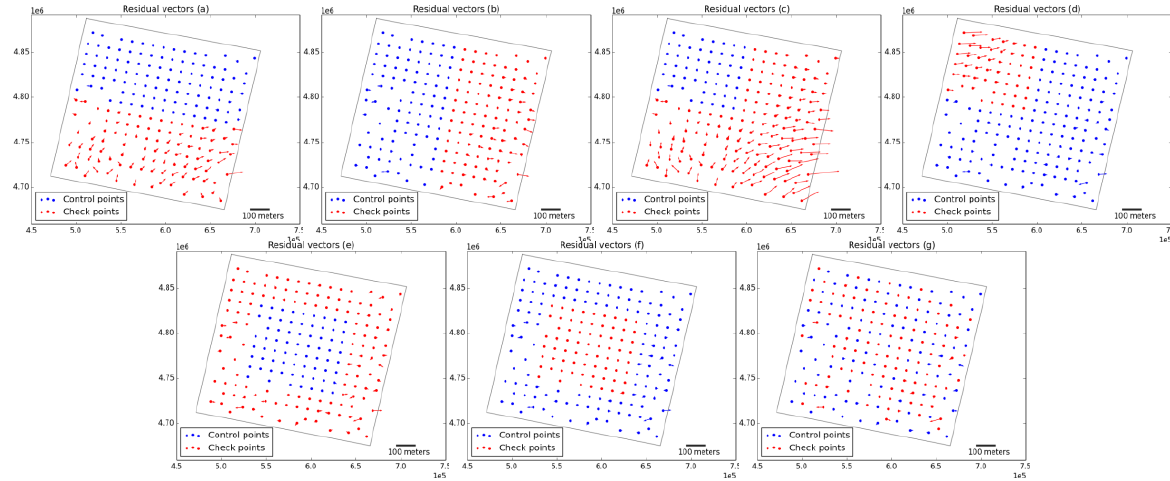
Figure 6. Residual vectors of rational function model (LS1)